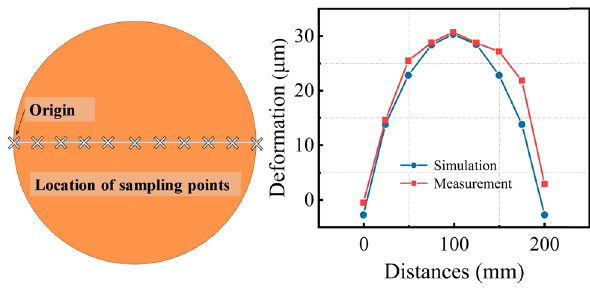
Figure 10: Comparison between simulation and experimental results of part deformation.